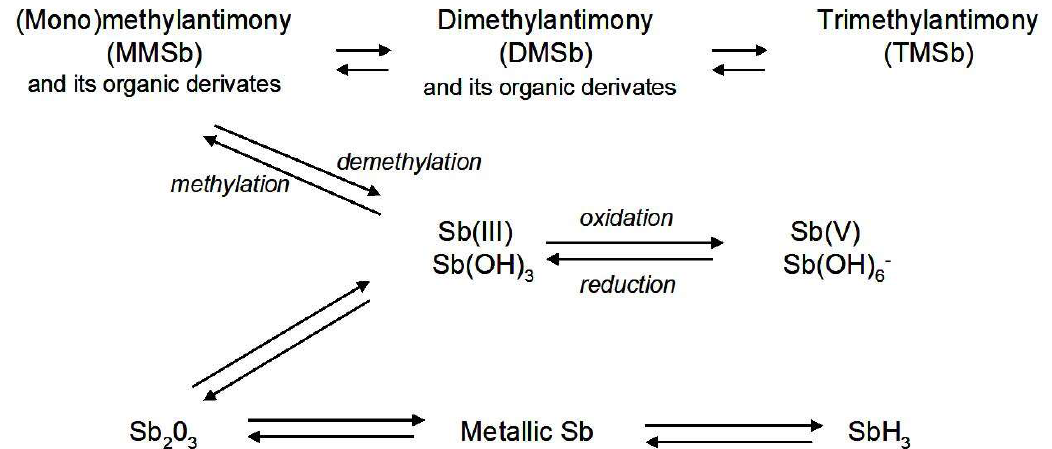
Figure 1. Microbial transformations of antimony (Sb)—a simplified scheme, from [17], which has been modified.